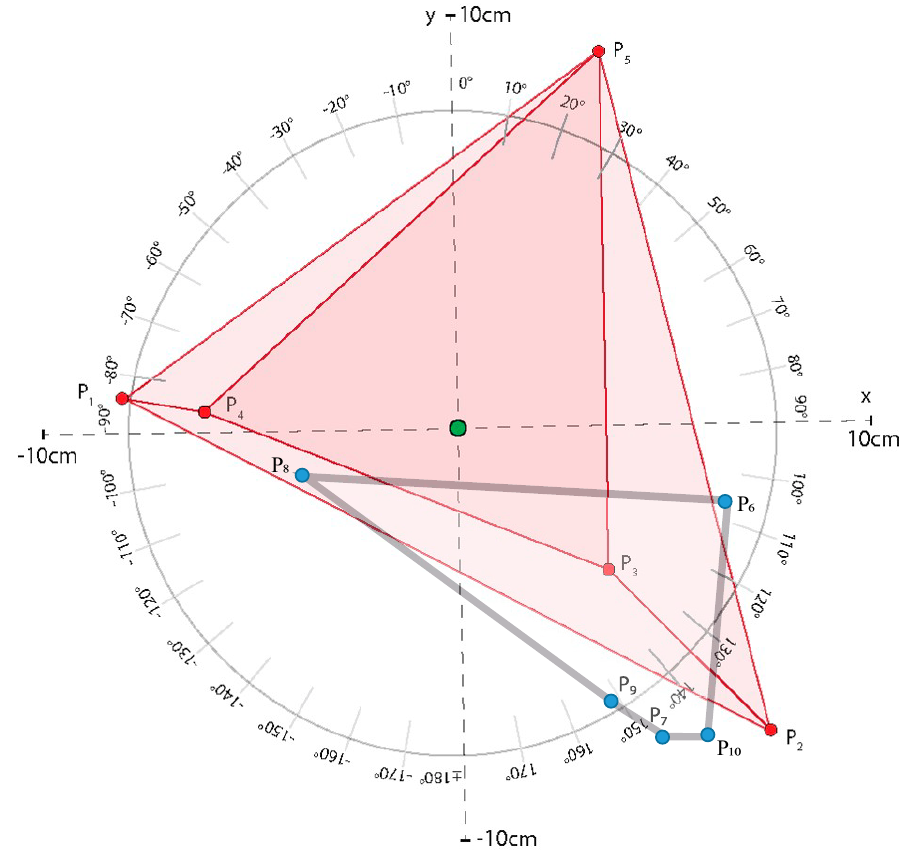
Figure 9. Each point, P i , on the diagram corresponds to the landing point for each attempt.